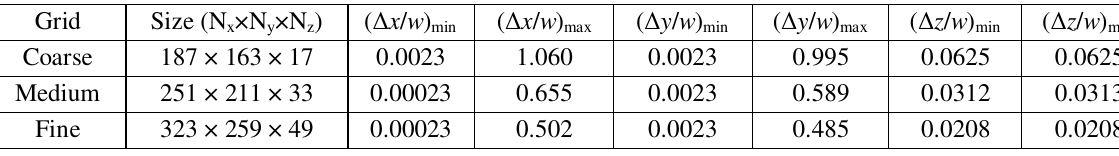
Table 1: Grid Details for the Single Square Cylinder